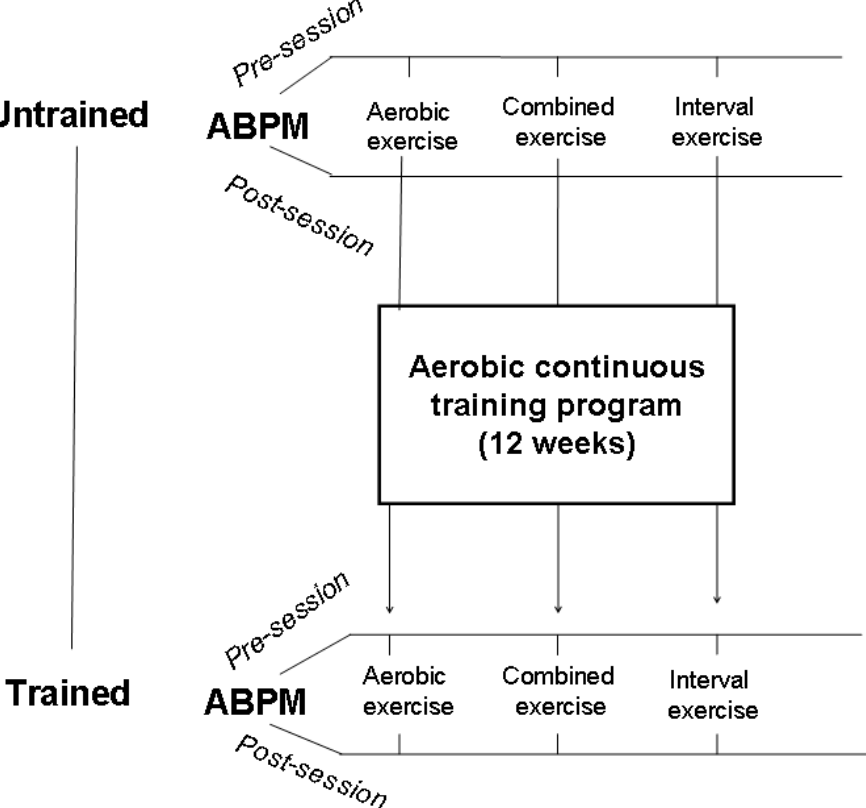
Figure 1. Flowchart of the study. ABPM, ambulatory blood pressure monitoring.